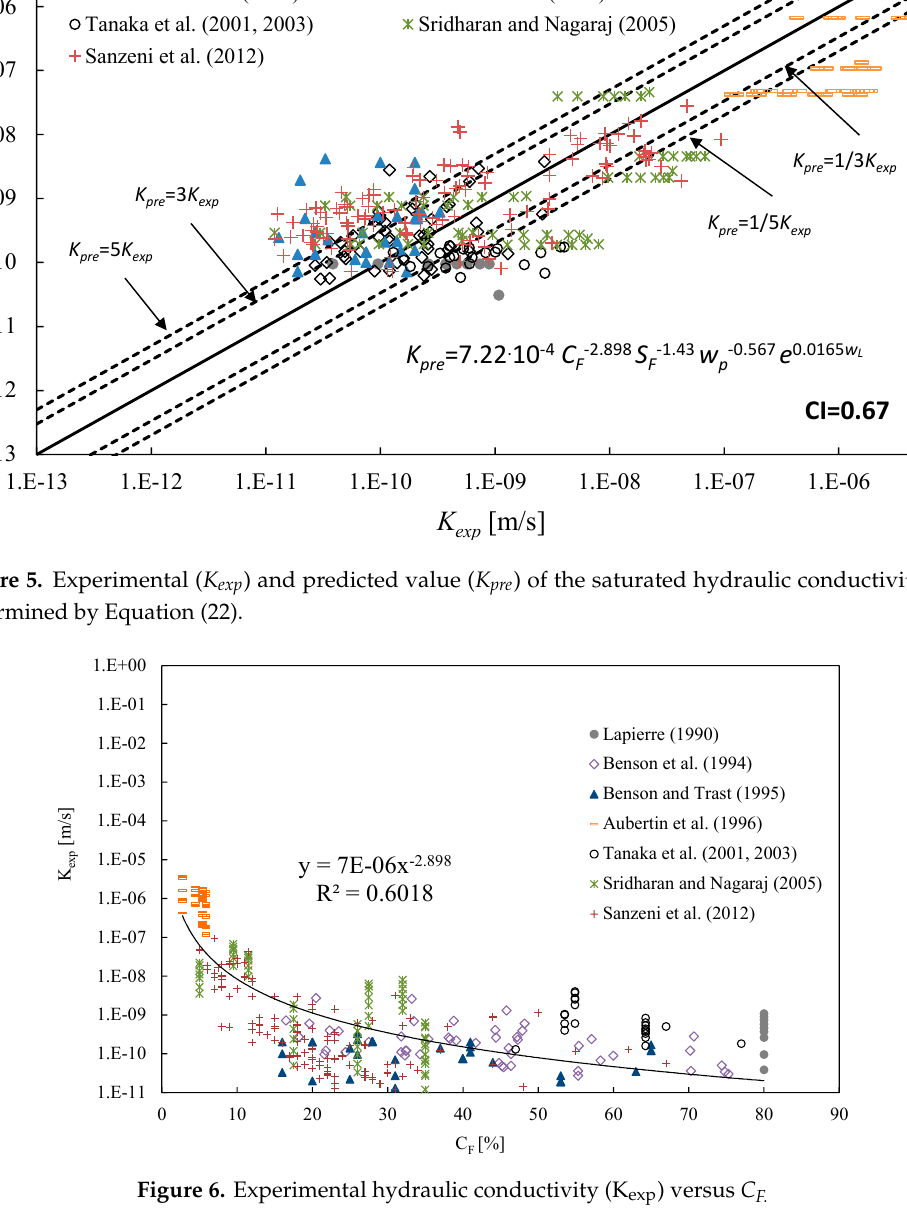
Figure 6. Experimental hydraulic conductivity (K exp ) versus C F.